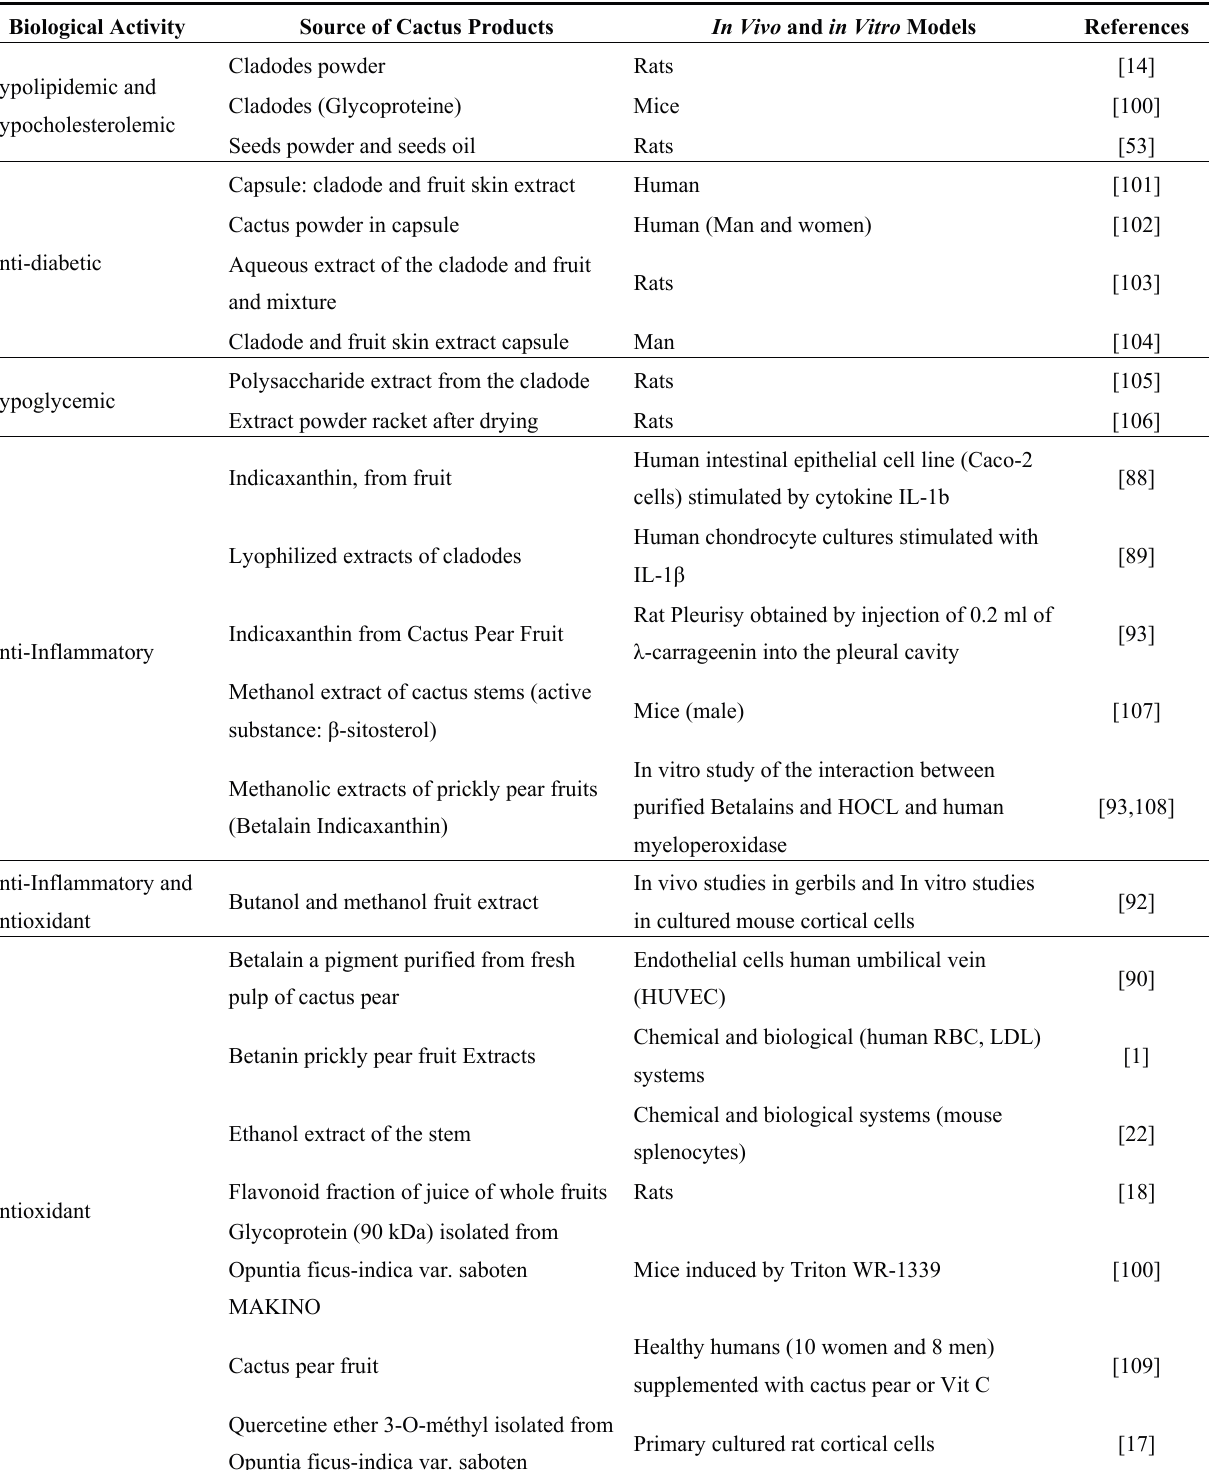
Table 8. Major bioactive effects of cactus preparations in different experimental